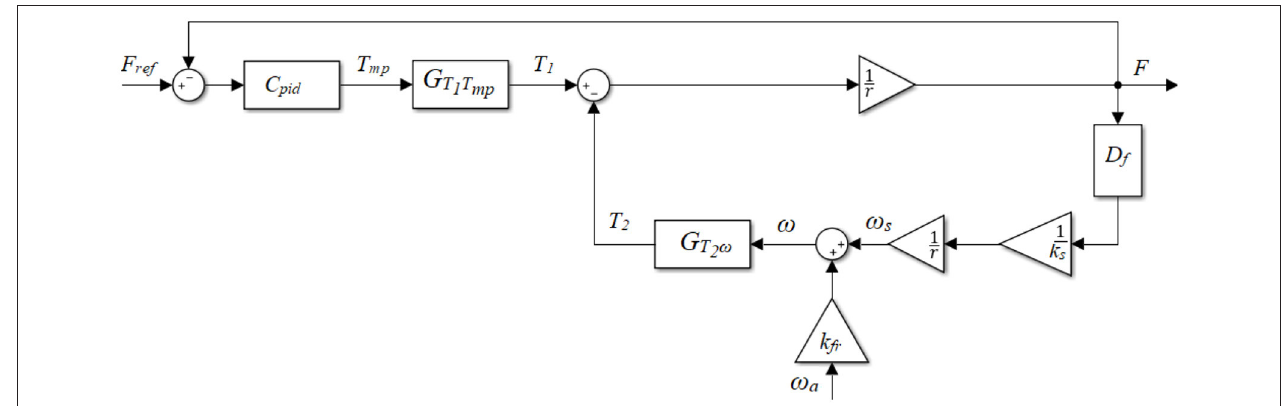
FIGURE 3 | Block diagram of the plant with the tentative PID controller.